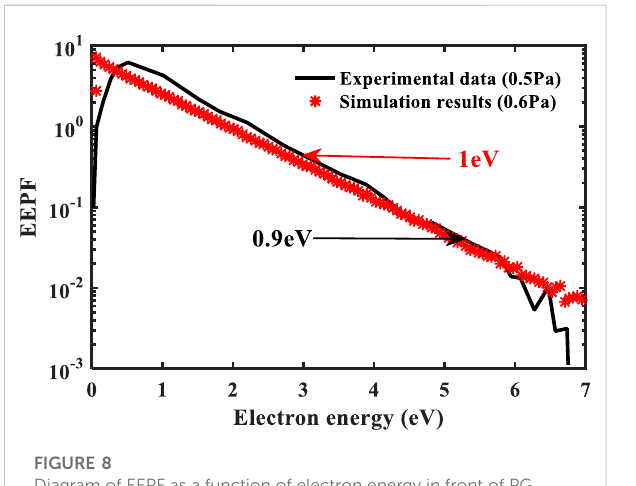
FIGURE 8 Diagram of EEPF as a function of electron energy in front of PG.